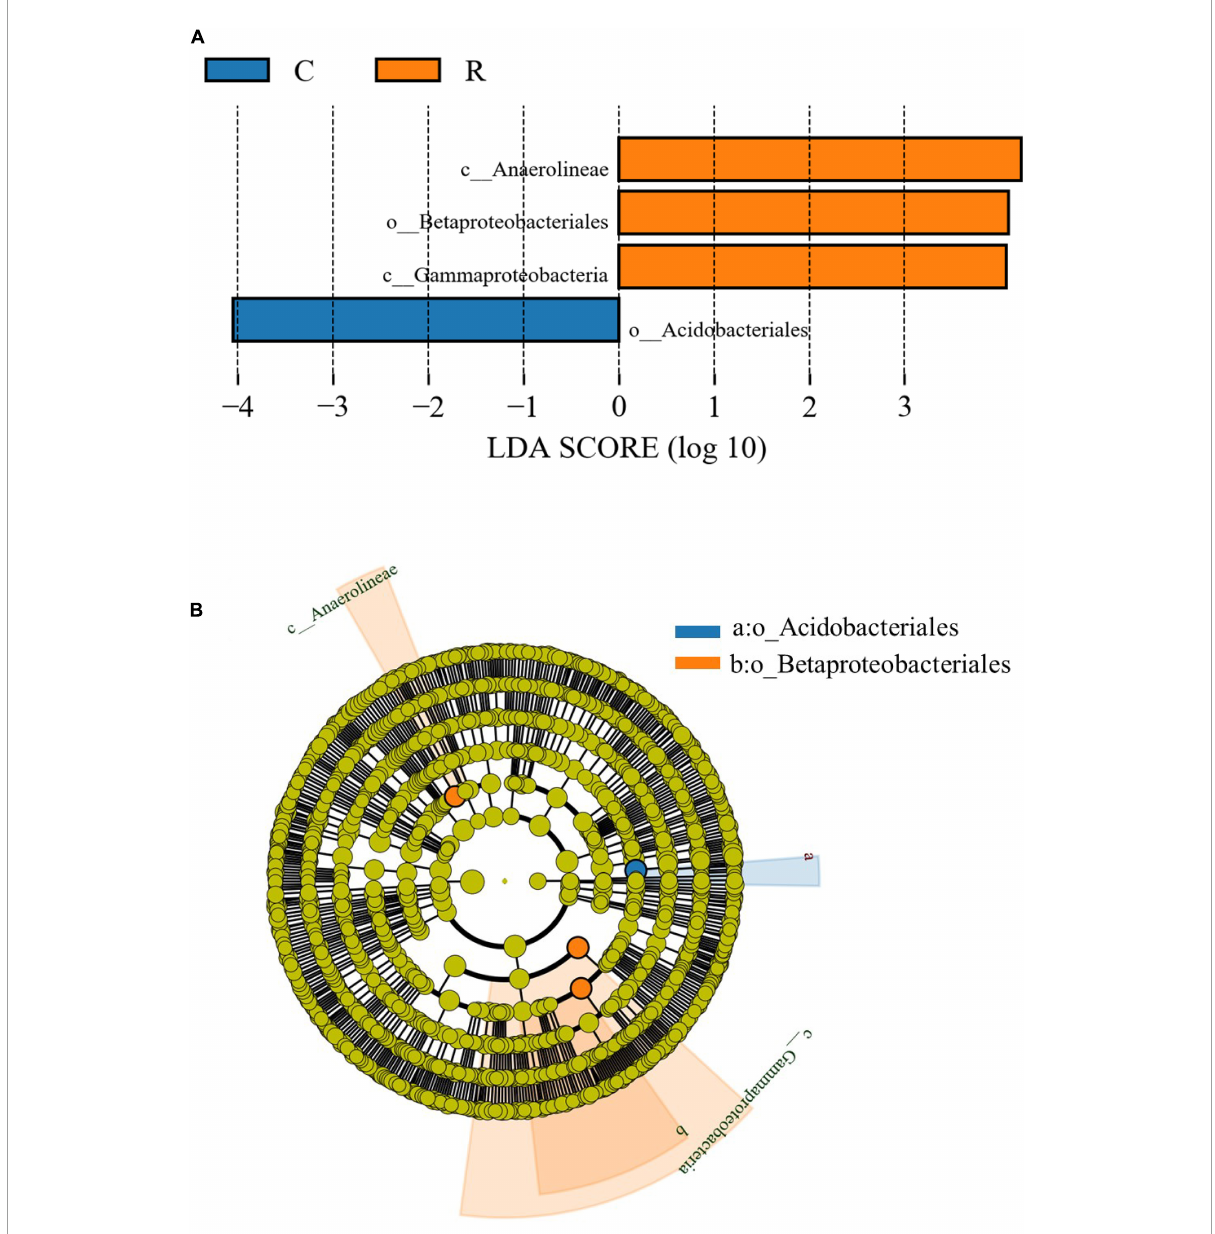
FIGURE4 Comparative linear discriminant analysis (LDA) effect size (LEfSe) results of soil bacterial abundance of tobacco continuous and tobacco-rice rotation cropping systems. (A) Identified biomarkers ranked by the effect size in different cropping systems and (B) LEfSe taxonomic